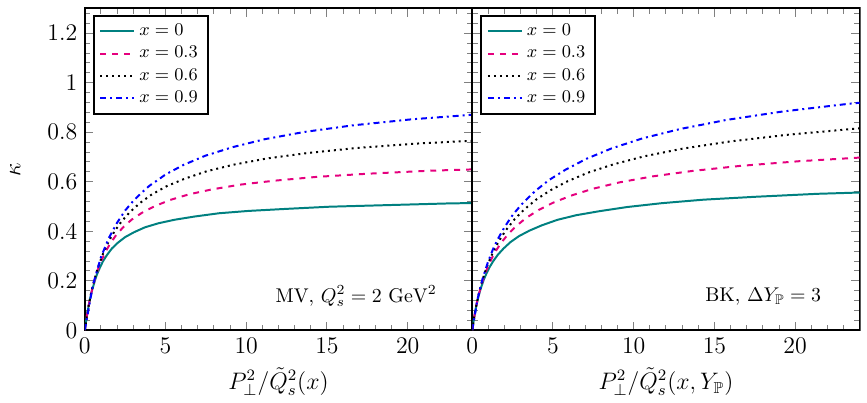
(cid:0) (cid:1) x, Y , P 2 / ˜ Q 2 ( x, Y ) , as introduced in s ⊥ P P / ˜ Q 2 ( x, Y ) for different values of x s ⊥ P = 0 , where T g ( R ) is given by P = 3 . T g ( R, Y ) is obtained P P = 0 given by the MV model. P = 3 P